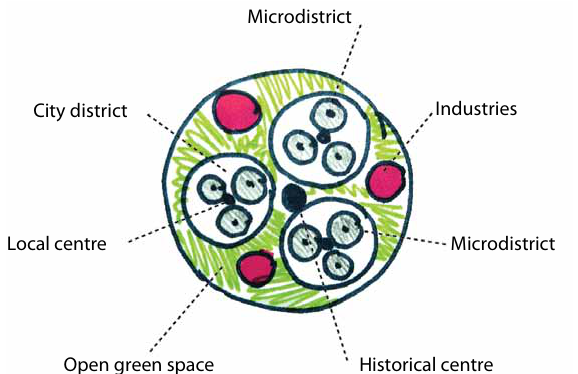
fig. 2. Scheme of the modern soviet city: microdistricts and large residential city districts surround historical city centre